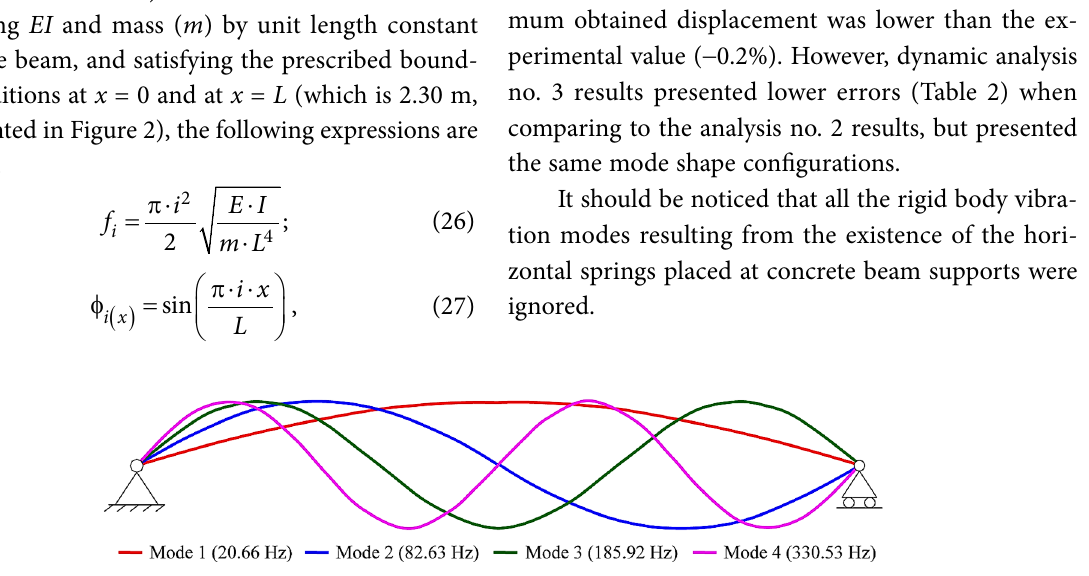
Fig. 9. Natural frequencies and vibration shape mode results of analysis no. 1 (analytical), for the first four beam vibration